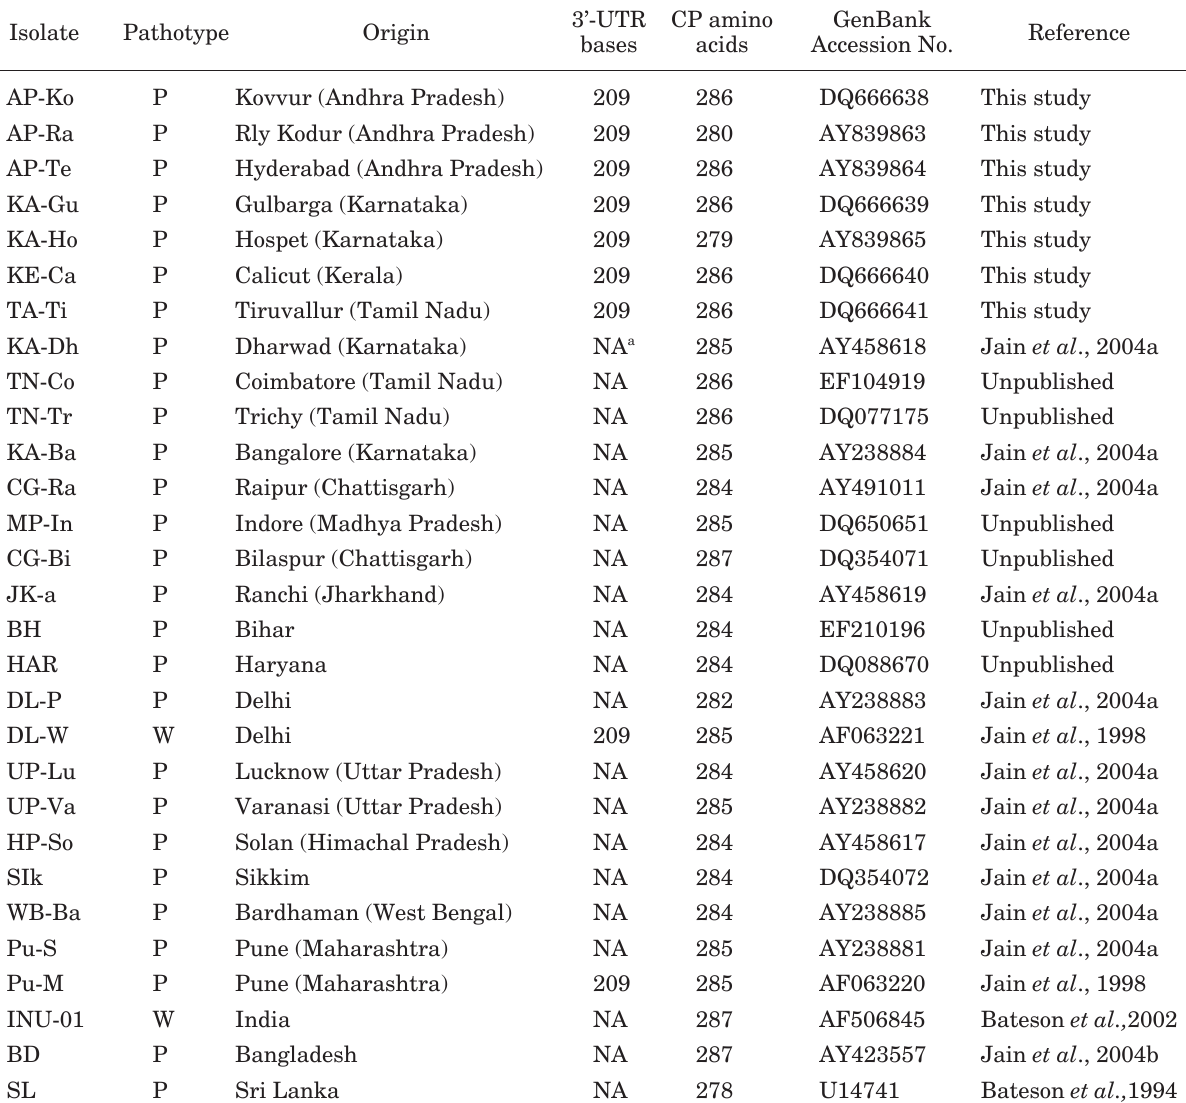
Table 2. Sources of CP gene and 3’- UTR sequences of PRSV isolates from Indian subcontinent used in this study for